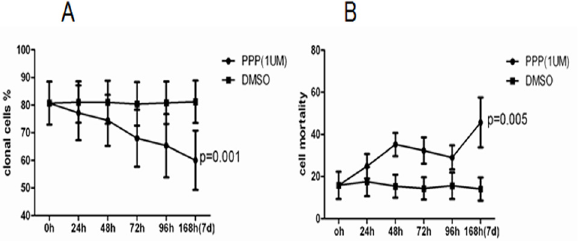
Fig 3. Changes in the cell mortality and the percentages of clonal cells at different time points after PPP intervention. After CD34 + cells from 6 MDS patients were amplified in vitro , PPP was added at a concentration of 1 μ M, and DMSO was used as a control. Cells at 0, 24, 48, 72, 96, and 168 h (7 d) after drug treatment were collected to calculate the mortality by Trypan Blue staining and smeared onto slides to detect the percentage of clonal cells using FISH. Over time, (A) the percentage of clonal cells progressively decreased. The P value resulted from the comparison between before PPP drug intervention (0 h) and 168 h (7 d) after intervention. The average percentage decreased from the initial 80.7 to 60.0%, and the difference was statistically significant. (B) The cell mortality increased over time and the difference from the control was statistically